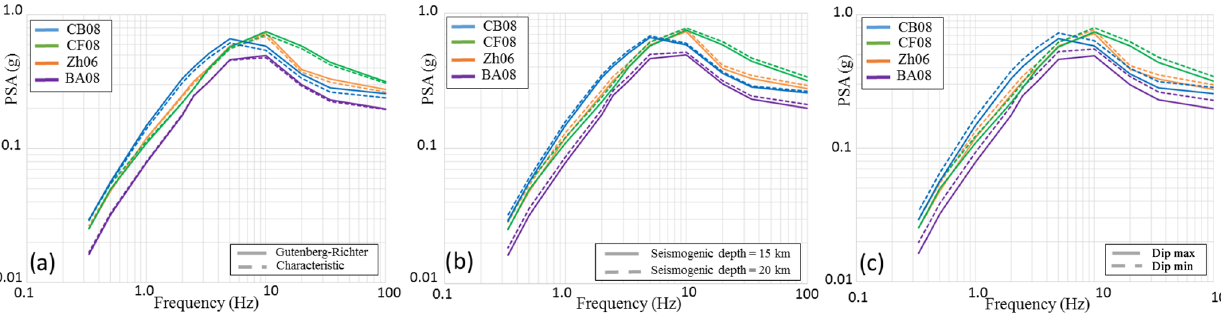
Figure 5. Impact of the different uncertainties explored in the logic tree on the UHS at 10000 years for the site of interest. (a) Shape of the MFD, (b) seismologic depth and (c) dip of the faults. The UHS of the reference branch is the solid lines in all figures.